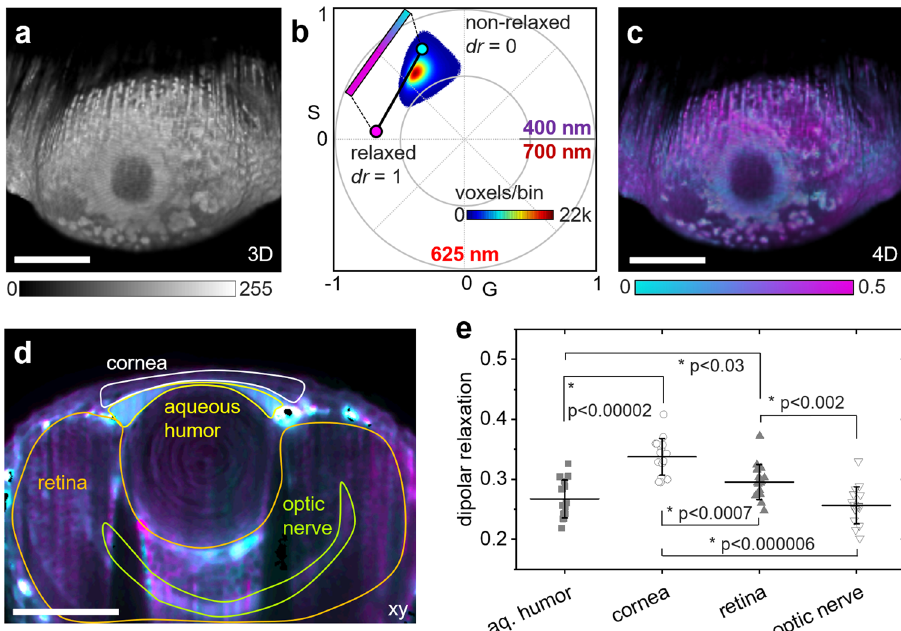
Fig. 7 Cell-wide water dipolar relaxation in live zebra fi sh embryos. a – e A live zebra fi sh embryo was incubated with the solvatochromic probe ACDAN before hyperspectral imaging with sine/cosine fi lters at 72 hpf. a MIP of 3D intensity image data obtained by two photon excitation with 800-nm light. b Spectral phasor plot obtained by fl uorescence collection though sine/cosine fi lters. The dipolar relaxation index, dr , was quanti fi ed by calculating the voxel positions along the trajectory indicated in the phasor plot with the endpoints de fi ned by the relaxed and unrelaxed state of ACDAN. c MIP of 4D spectral data color coded according to the voxel position along the phasor plot trajectory of ACDAN shown in b . d Single color-coded z section of the 3D volume. e Quanti fi cation of the dipolar relaxation index, dr , obtained along the phasor plot trajectory in multiple regions of interest as indicated in d . Each point represents the average dr in one xy/yz slice. Error bars indicate the standard deviations. Stars (*) indicate signi fi cant ( p < 0.05) differences between groups as determined by the Mann – Whitney U test, N = 16 z sections each. Representative images of three different zebra fi sh embryos imaged on three different days. Scale bars, 100 µ